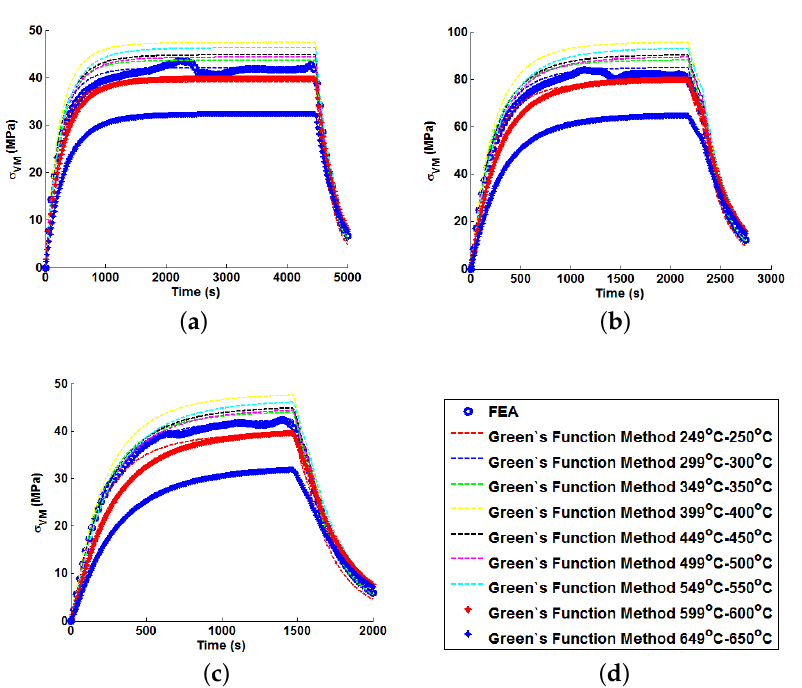
Figure 8. Predictions of thermal stress responses determined using individual Green’s functions for: ( a ) ramp up Profile A; ( b ) ramp up Profile B; and ( c ) ramp up Profile C. Sub figure ( d ) shows the legend used in the plots.